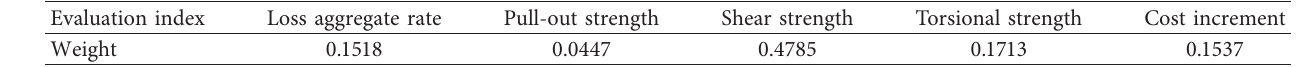
Table 8: The weight of evaluation indexes.